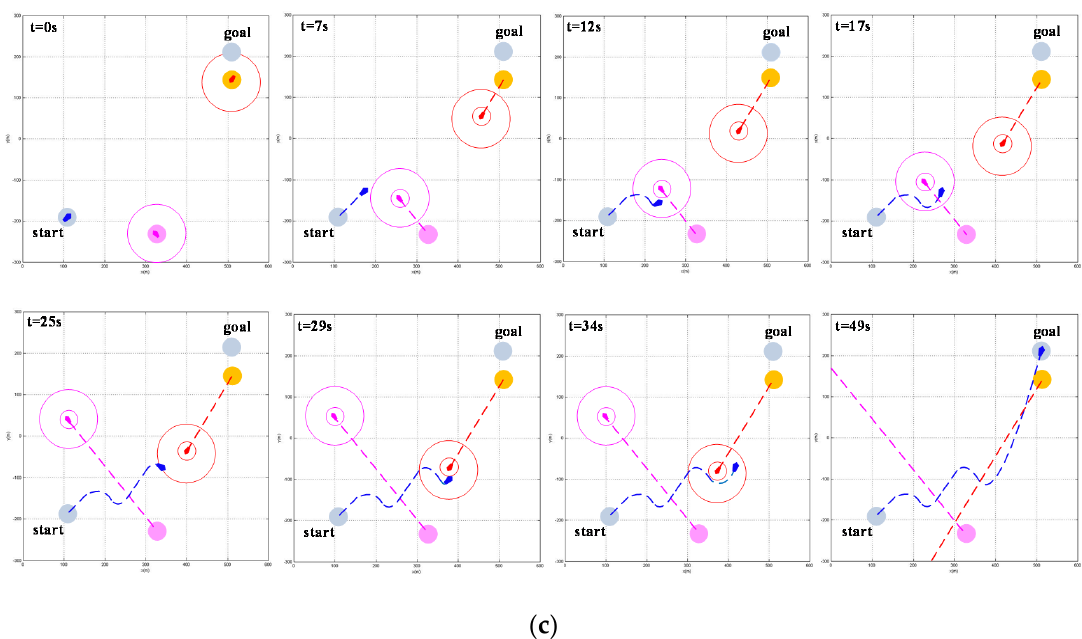
Figure 14. Obstacle avoidance process in the multi-vessel encounter situation: ( a ) Obstacle avoidance process based on improved VO autonomous obstacle avoidance algorithm; ( b ) Obstacle avoidance process based on VO autonomous obstacle avoidance algorithm; ( c ) Obstacle avoidance process based on SBG autonomous obstacle avoidance algorithm.